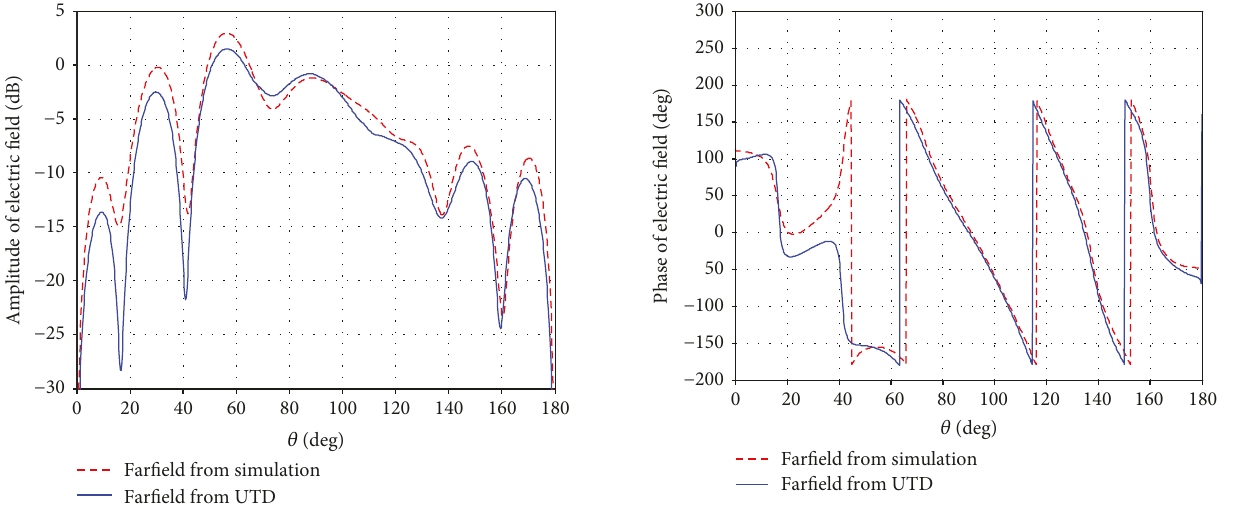
Figure 13: Phase of electric fi eld of the θ component in the ϕ =40 ° plane with w =4 λ and h =1 λ , at 4GHz compared with simulation result.